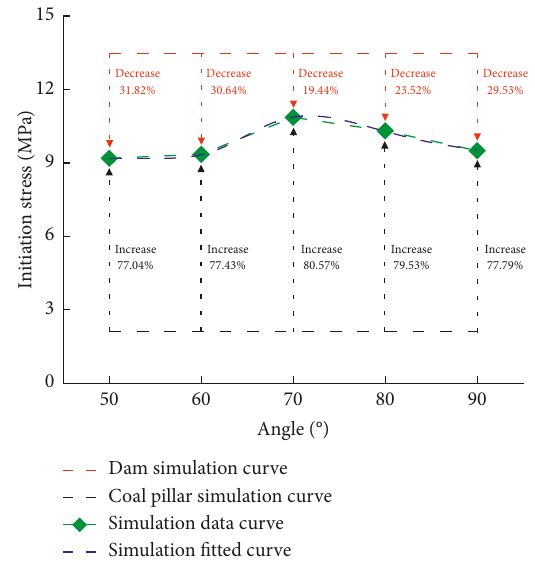
Figure 16: Relationship between angle and initiation stress.